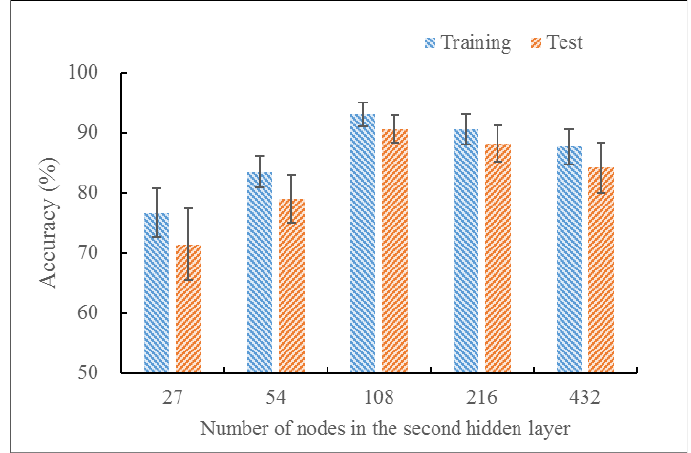
Figure 11. Accuracy results of different number of neurons in the second hidden layer.